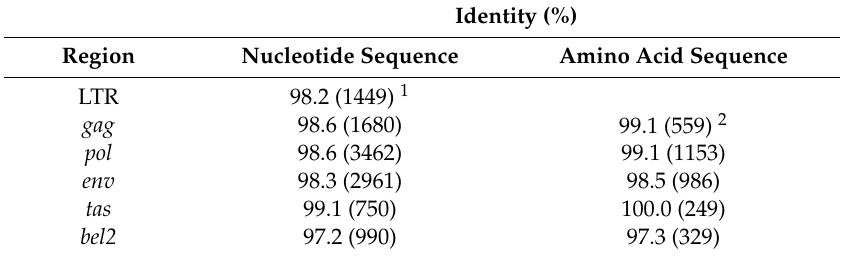
Table 4. Identities of nucleotide sequences and amino acid sequences of an isolated virus and EFV.